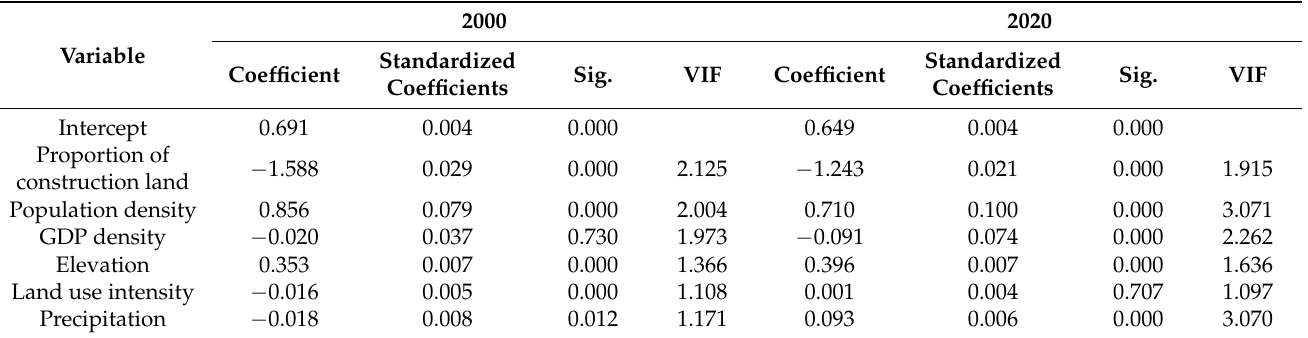
Table 1. Result of the OLS model at the 5 km grid scale.